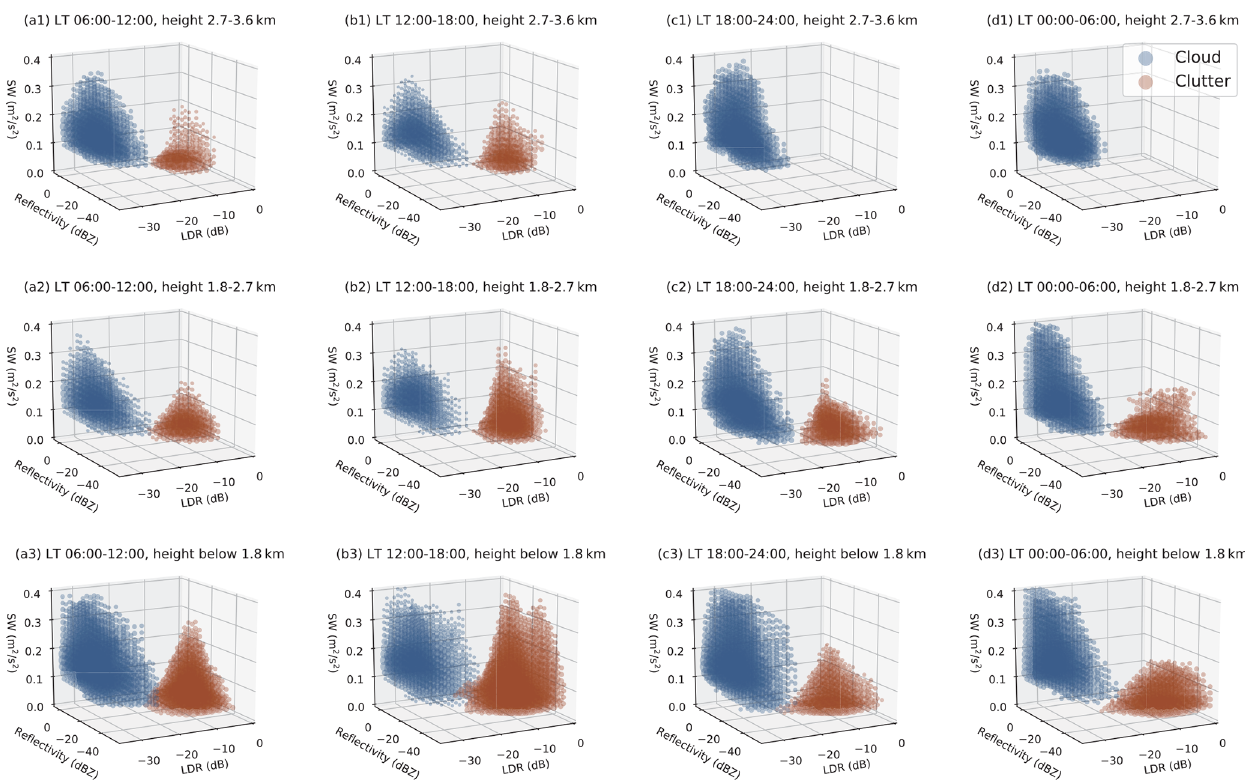
Figure 6. Same as Fig. 5 but for the cold season (October to